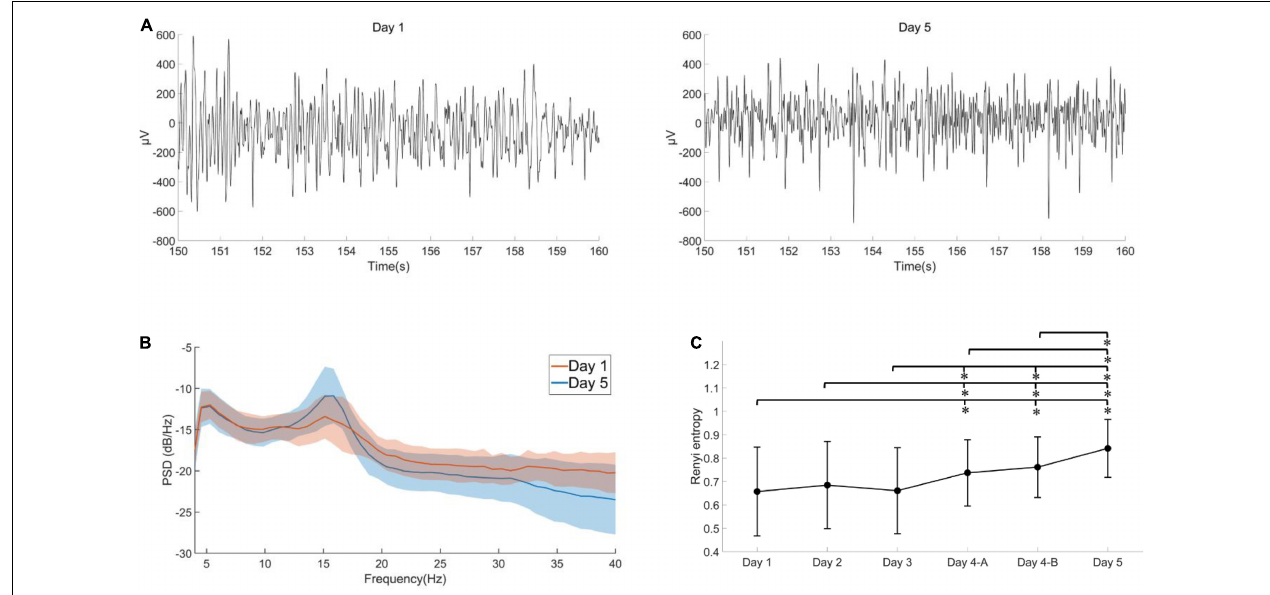
FIGURE 3 | The analyzed results of PFC EEG. (A) 10 s filtered EEG data from Day 1 and 5. (B) The average power spectral density (PSD) of Day 1 (blue) and Day 5 (orange), the shade indicates the standard deviation of the PSD. The PSD value on Day 5 in the 13–18 Hz band is lower than that of Day 1. (C) The Rényi entropy of EEG over six assessment sessions. The Rényi entropy significantly increased over six sessions ( p < 0.05, ANOVA), and it was significantly higher in the last session than in the first day. Day 4-A was the first assessment in day four, day 4-B was the second assessment in day four.